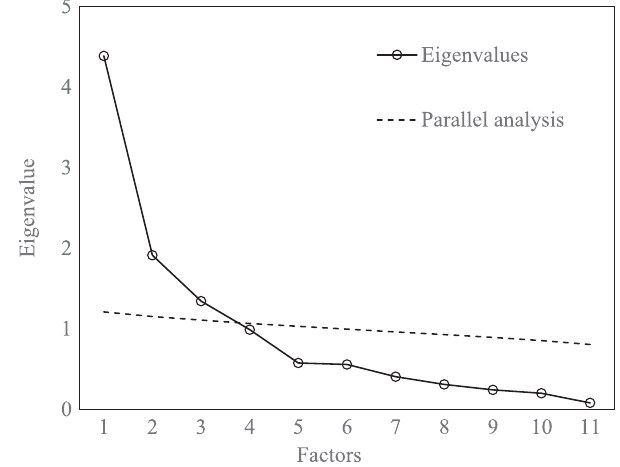
FIG. 2. Scree plot of EFA eigenvalues of the U.S. students ’ post-test data. The dashed line represents the eigenvalue trend line of the parallel analysis.